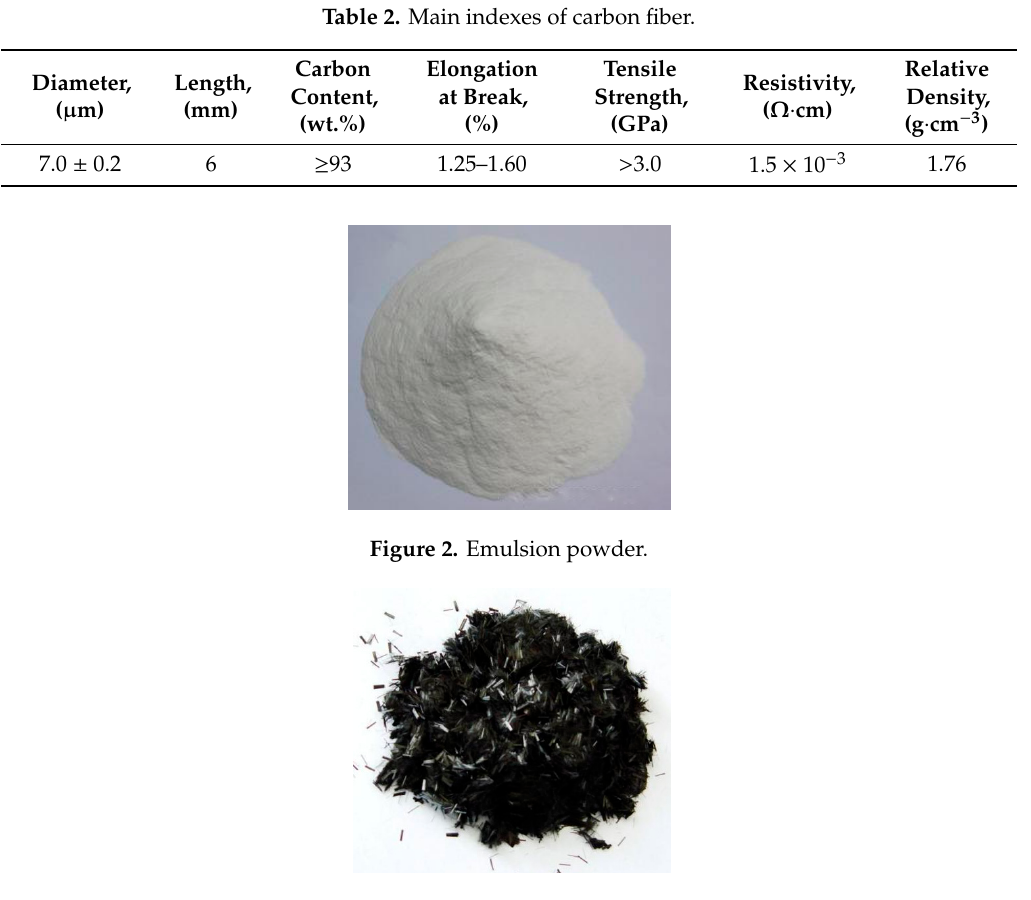
Table 1. Main indexes of redispersible emulsion powder.